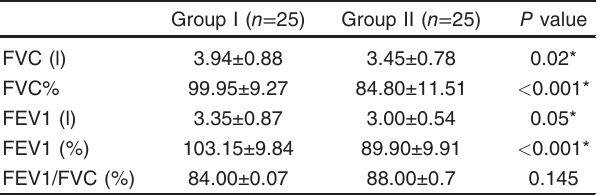
Table 3 Comparison between the patients in group I and group II in terms of pulmonary function tests values